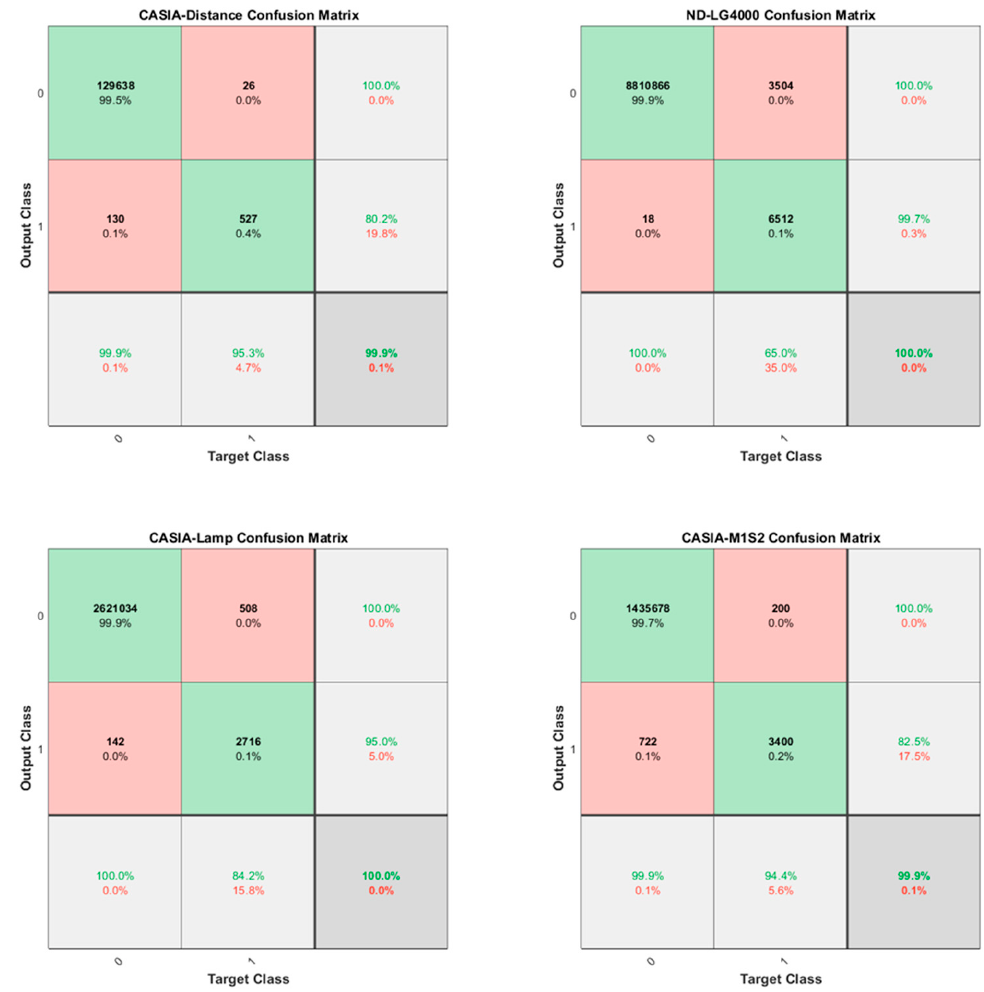
Figure 8. Obtained confusion matrix of the proposed model for iris recognition.